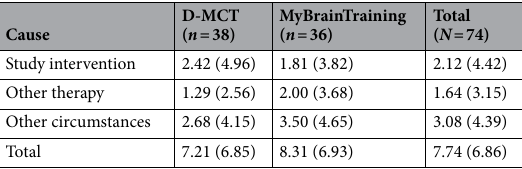
Table 3. Mean number of negative effects broken down by cause (standard deviations in brackets).